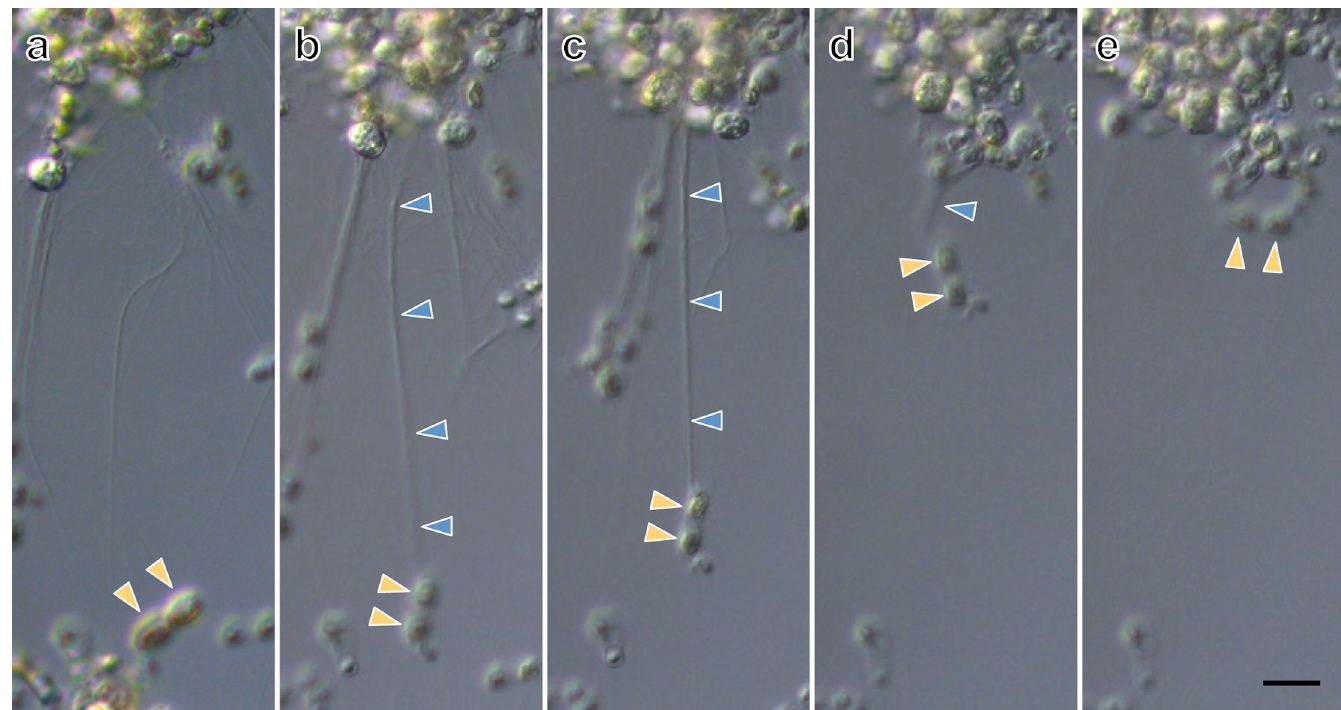
Fig 2. Continuous observation of aggregate formation with Skeletonema cells by ectoplasmic nets of Aplanochytrium . (a) Two-membered culture of Aplanochytrium (SEK 717) and Skeletonema (NIES 324). (b) Tip of ectoplasmic nets (blue arrowheads) of Aplanochytrium adhering to Skeletonema cells (orange arrowheads), 0 min. (c) Skeletonema cells (orange arrowheads) are gradually drawn towards aggregate by ectoplasmic nets (blue arrowheads), 45 min. (d–e) Skeletonema cells (orange arrowheads) moving near aggregate, 165 and 215 min. Scale bar = 10 μ m. These continuous observation images can be viewed as a time-lapse video movie (S2 Movie).